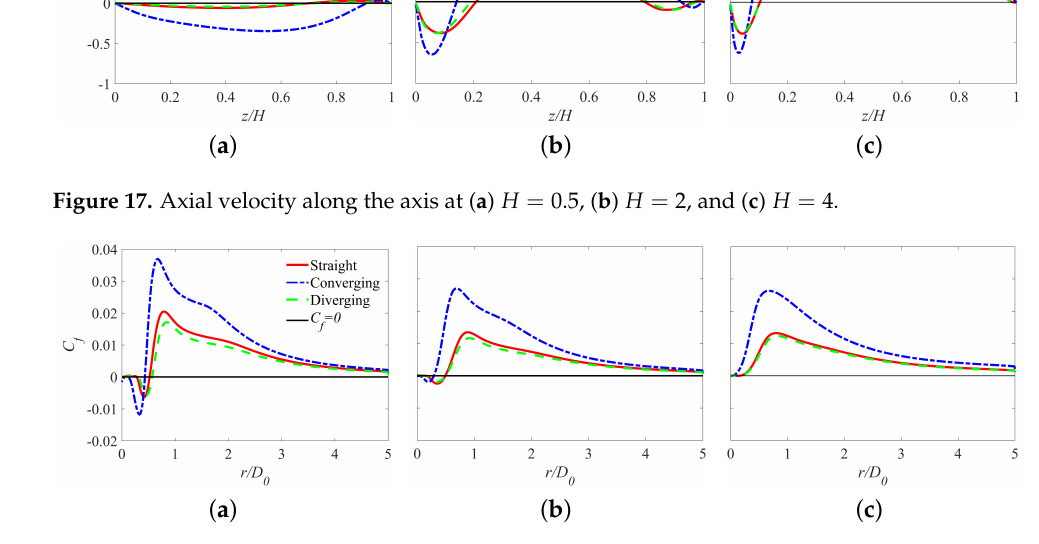
Figure 18. Radial skin friction C f on the target surface at ( a ) H = 0.5, ( b ) H = 2, and ( c ) H =